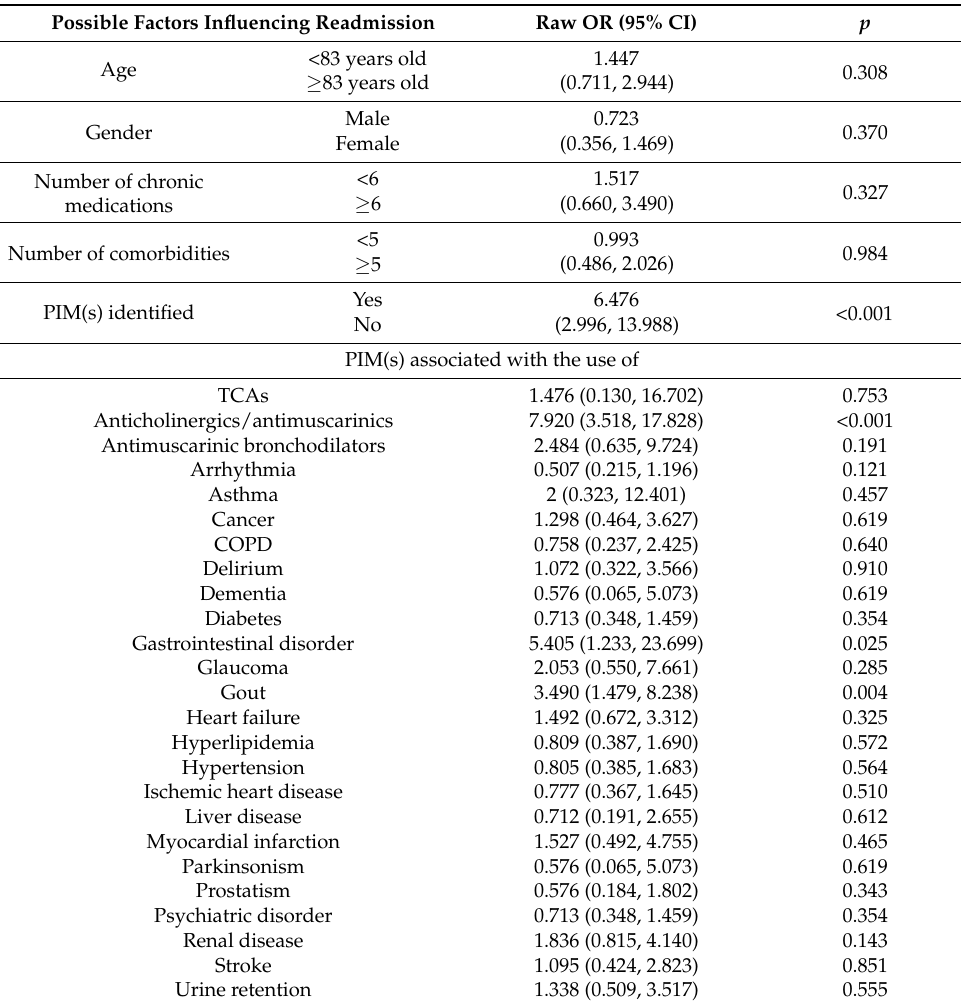
Table 4. Simple logistic regression analysis of the association between early hospital readmission within 28 days and various